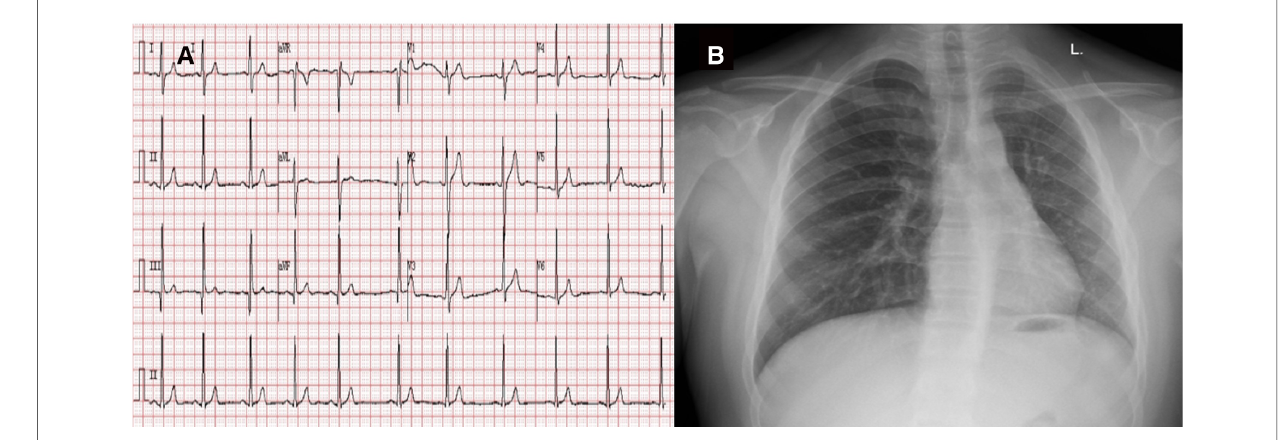
FIGURE 2 Preoperative ECG ( A ) and chest x-ray ( B ). Preoperative electrocardiogram indicated sinus arrhythmia and chest x-ray showed normal chest